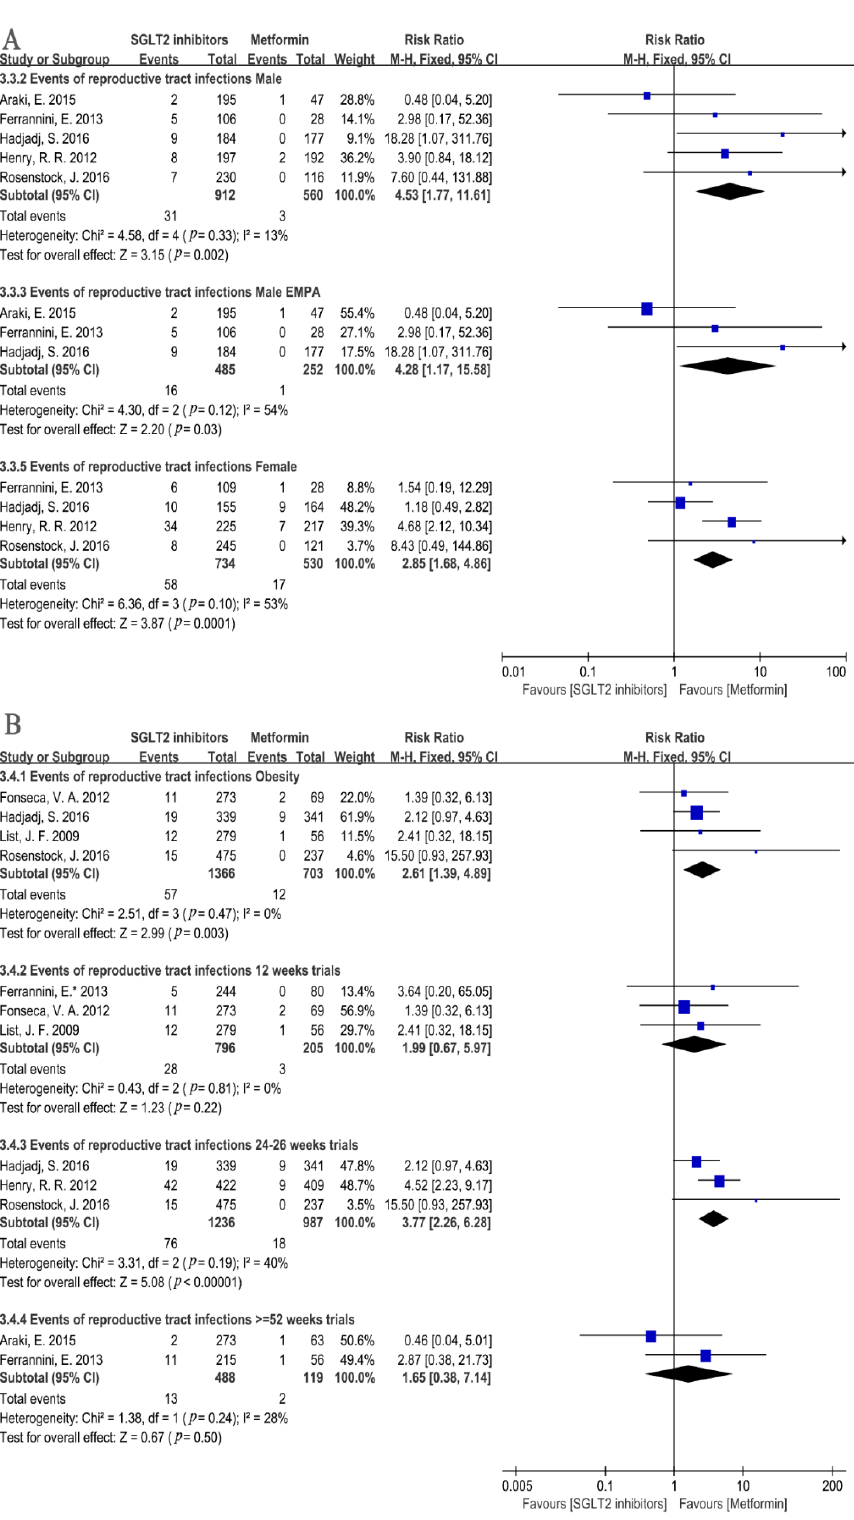
Figure 9. ( A ). Risk of reproductive tract infections in SGLT2i group compared with that of metfor- min [20 – 25,29,31]. ( B ). Risk of reproductive tract infections with EMPA and its different doses com-